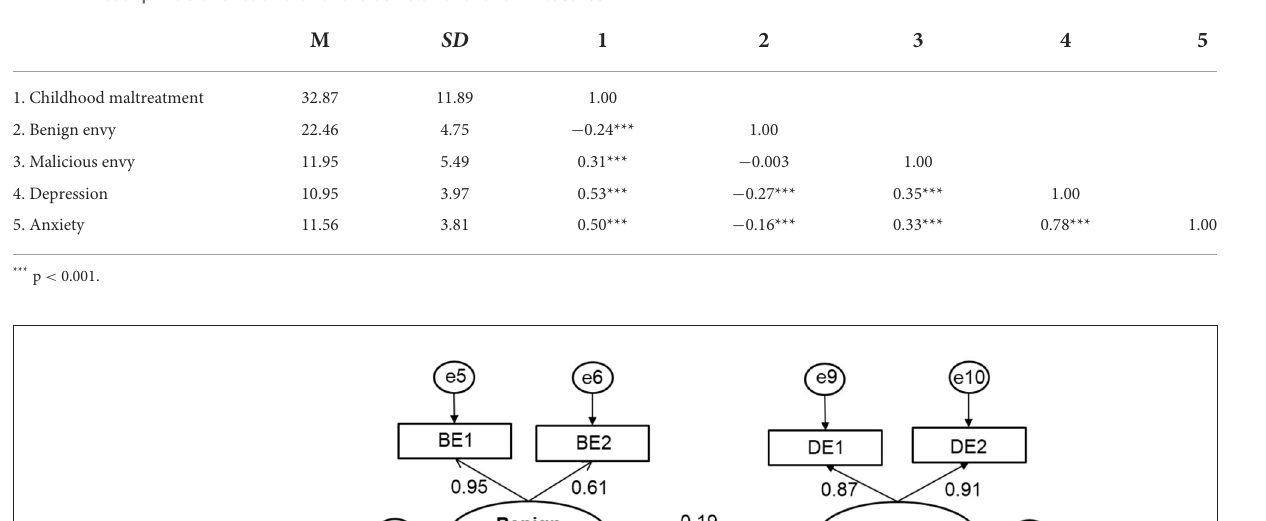
TABLE 2 Descriptive statistics and bivariate correlations for all measures.